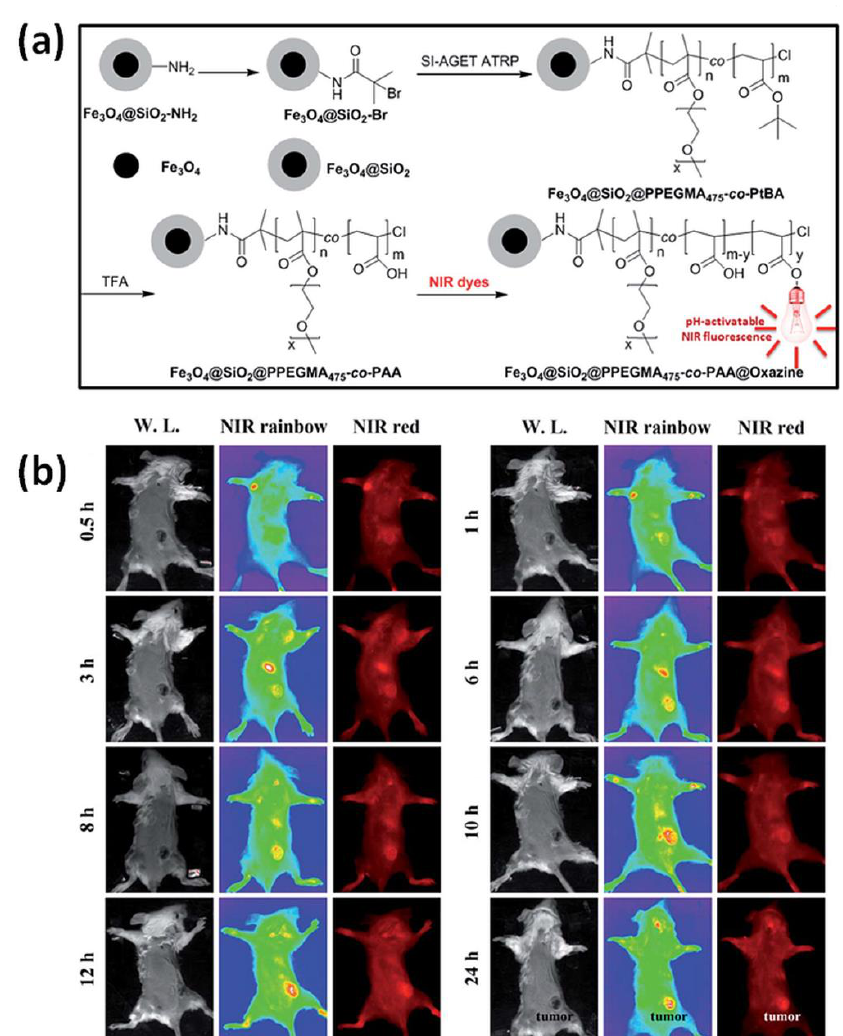
Figure 6. ( a ) Synthetic route for the preparation of MNPs characterized by bifunctional properties i.e., NIR fluorescence and magnetism by iron-mediated SI-AGET ATRP, subsequently modified by pH-activatable benzo[ a ]phenoxazine derivatives; ( b ) In vivo NIR fluorescence images of prepared hybrid material in 4T1 tumor-bearing mouse at indicated times after intravenous administration [135]. Reprinted with permission from Royal Society of Chemistry, Copyright